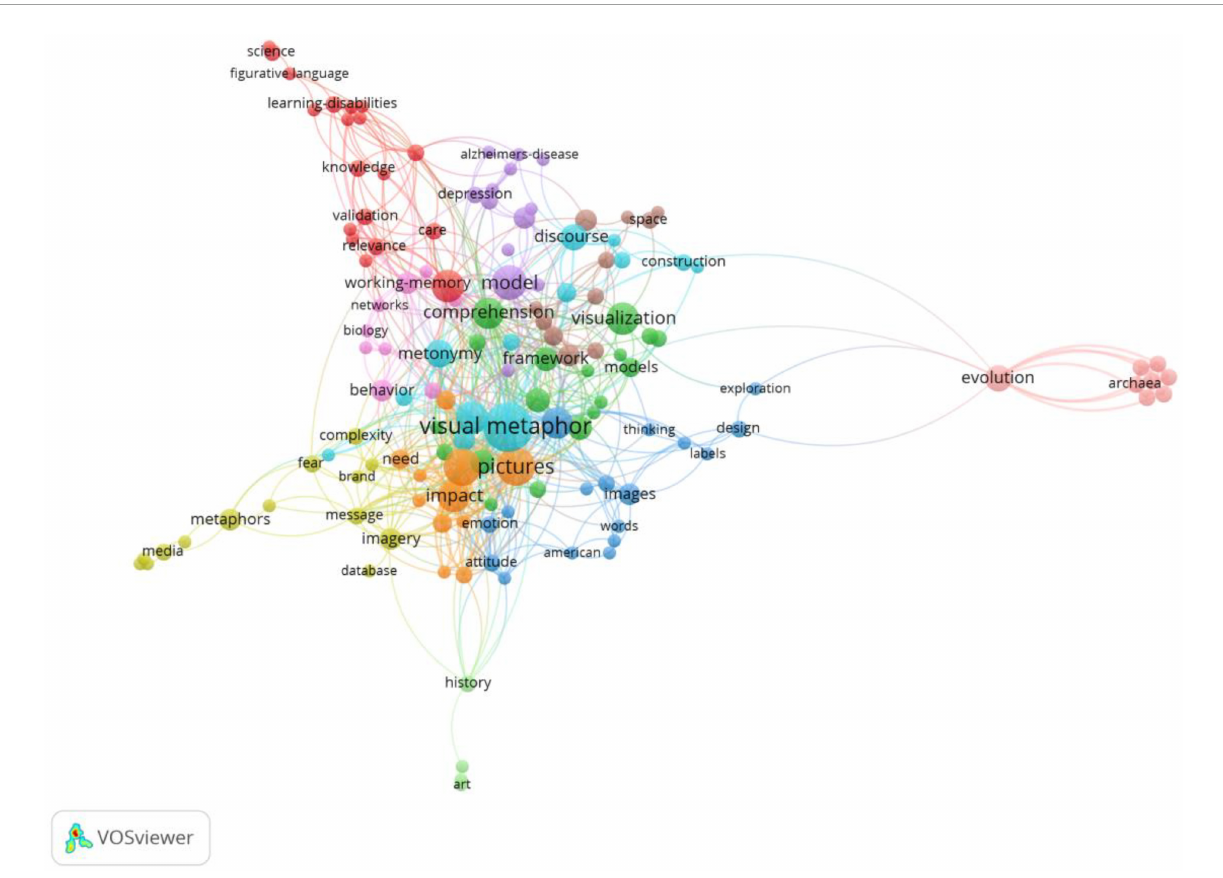
FIGURE10 VOSviewer network map showing the co-occurrence of key word plus (mini occurrences of a key word = 2; visualization by weight of